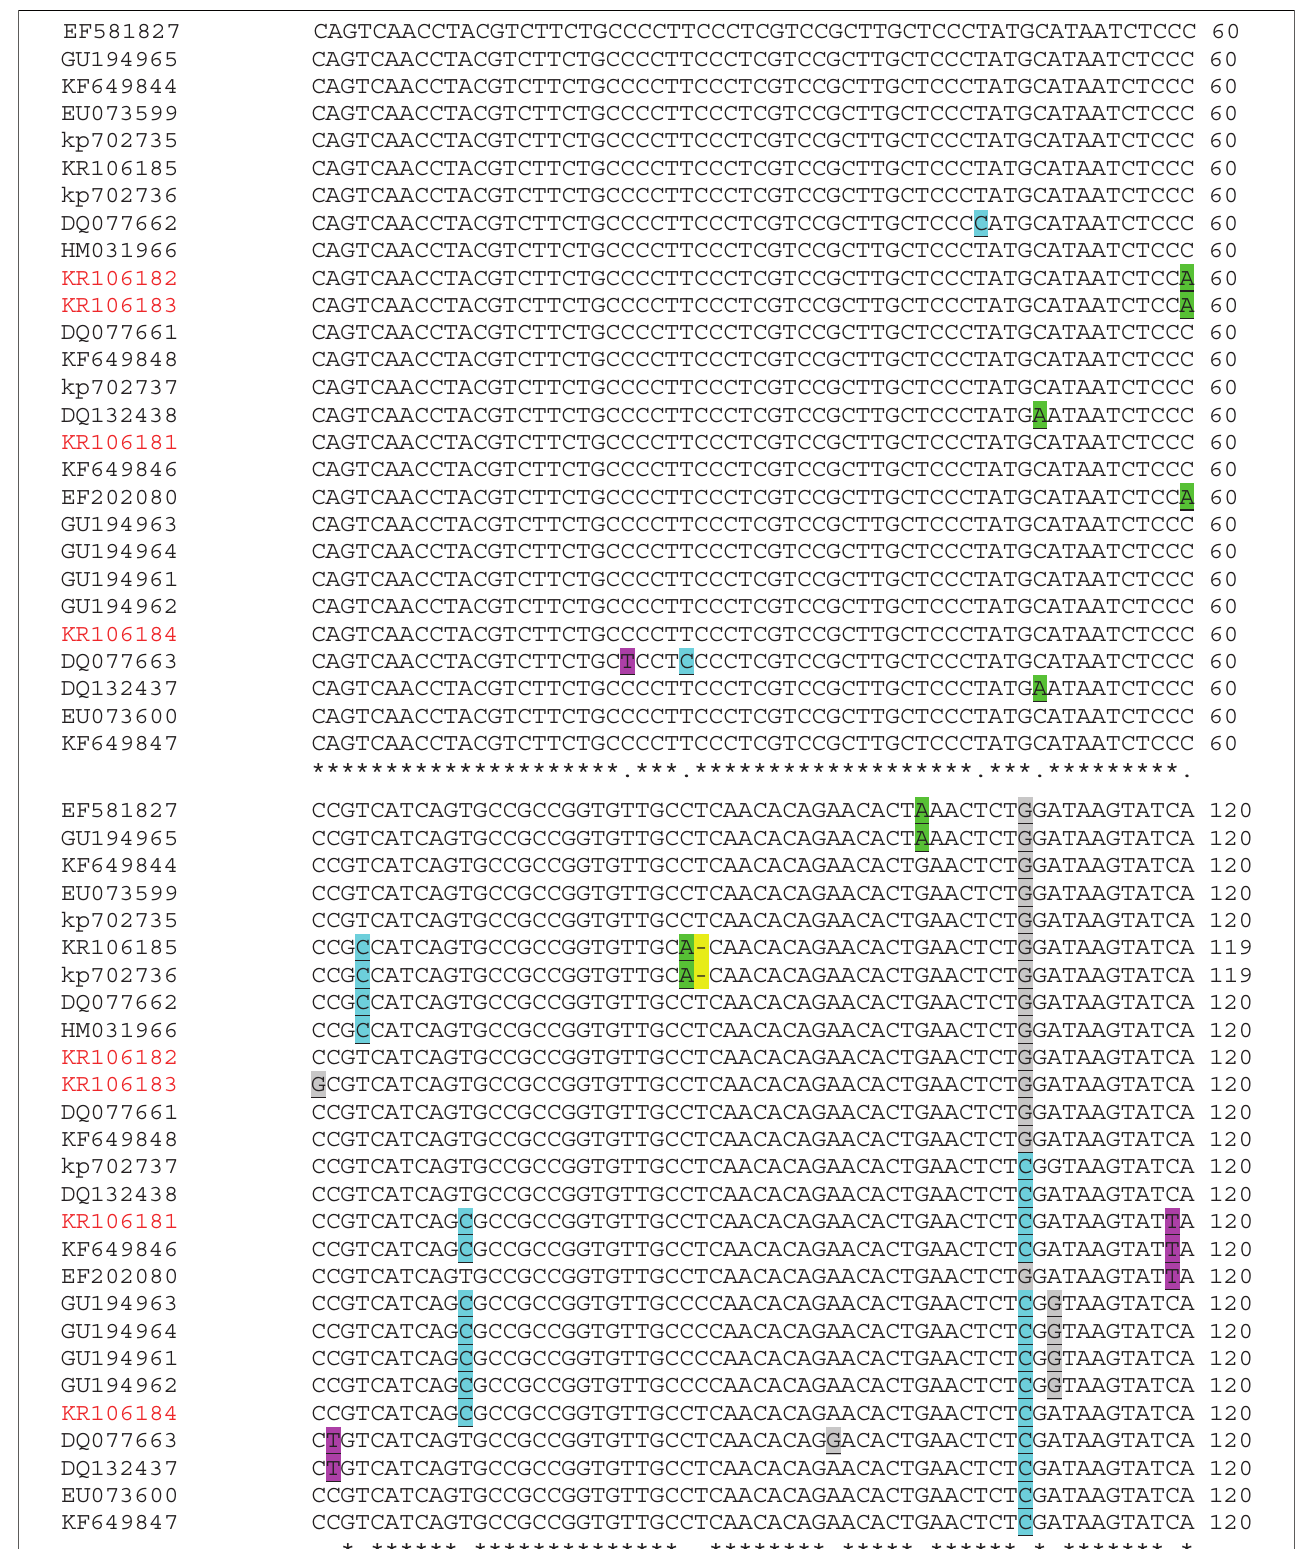
FIGURE 1-A1: Sequence alignment of Nc-5 gene of Neospora caninum from mammalian and bird